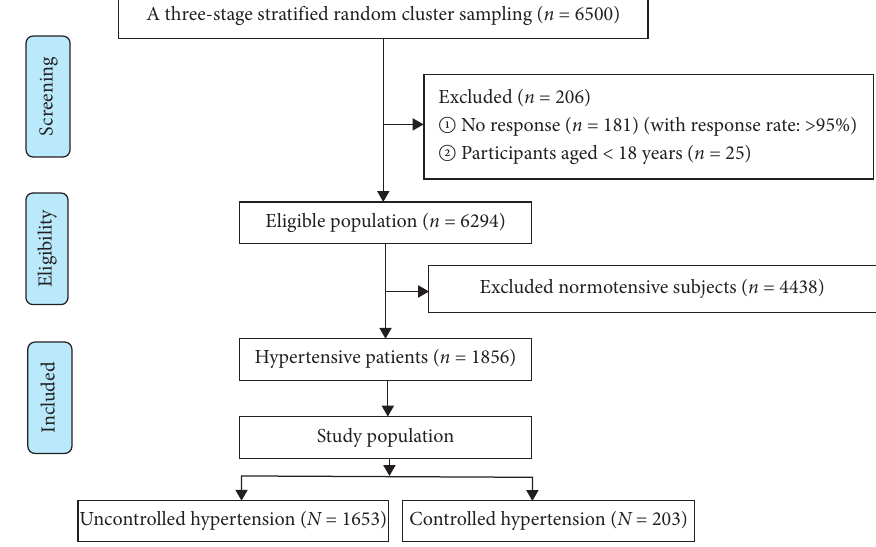
Figure 1: The flow chart of inclusion and screening of surveyed